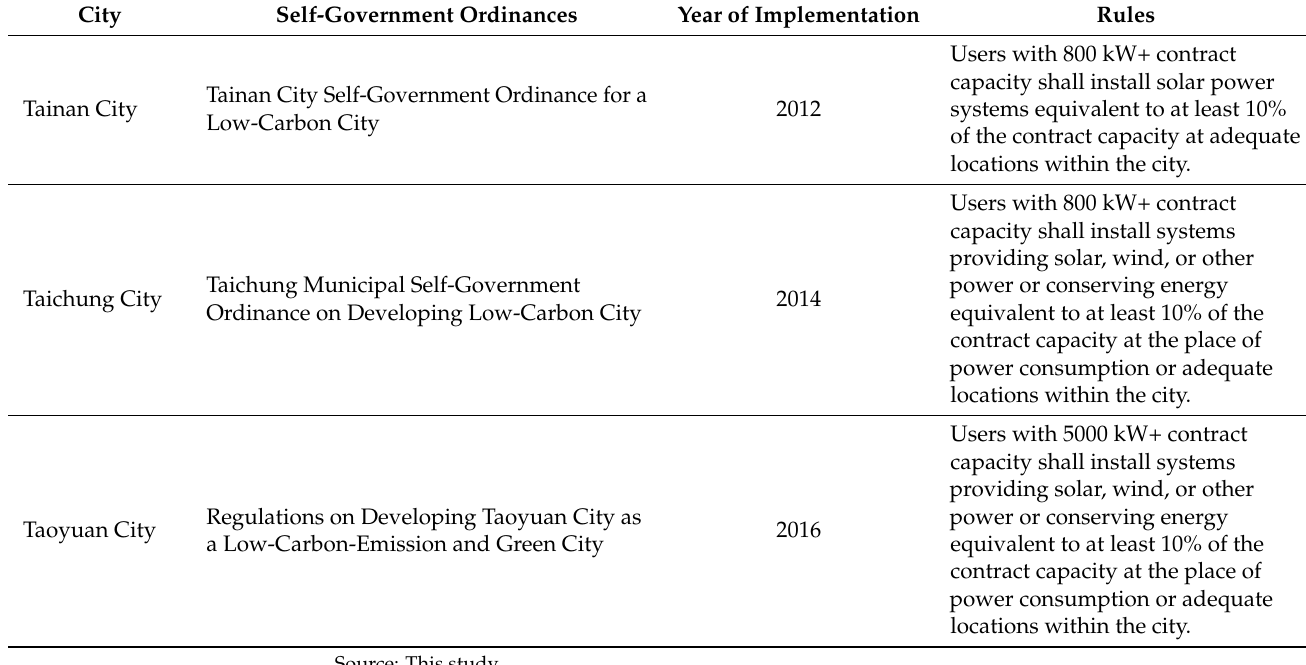
Table 4. RPS rules at the local government level.